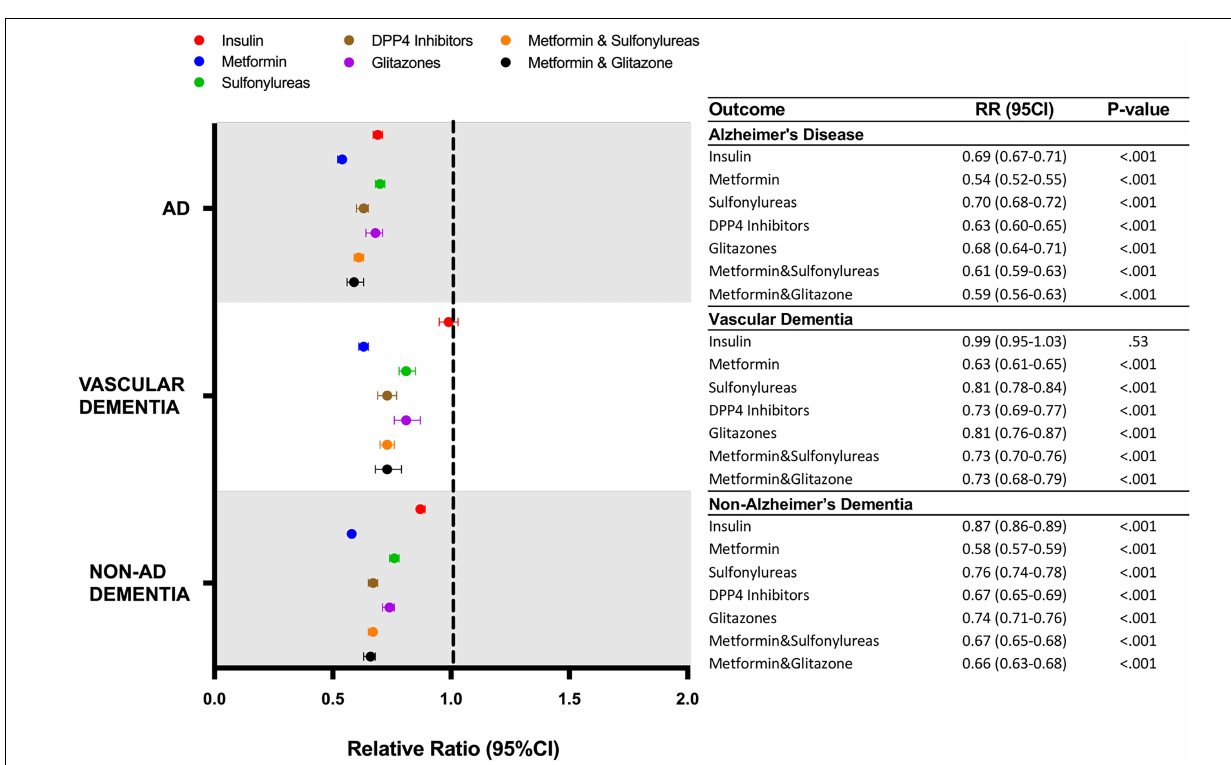
FIGURE 4 | Relative risk of developing AD or ADRD for T2D patients receiving different classes of anti-hyperglycemic medication. AD, Alzheimer’s disease; DPP4, dipeptidyl-peptidase 4; RR, relative risk; CI, confidence interval.